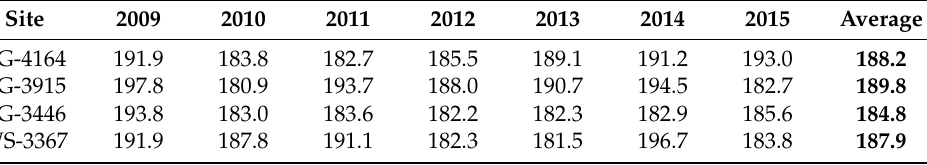
Table 3. As in Table 2, but for PCP (unit: degree in direction).